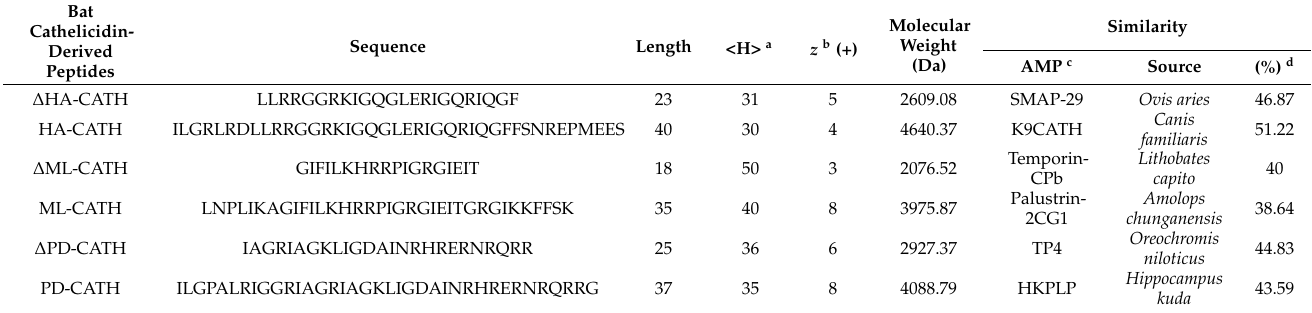
Table 1. Biochemical characteristics of bat cathelicidin-derived